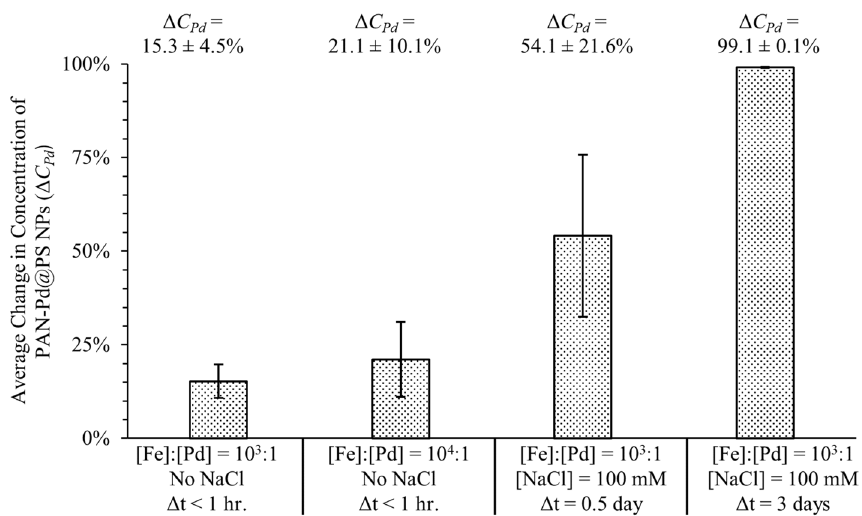
Fig. 3 Conditions for optimal removal of PAN-Pd@PS NPs. Average decrease in concentration of PAN-Pd@PS NPs in suspension (Δ C Pd ) in response to varying [Fe]:[Pd] mass concentration ratio, concentration of NaCl, and interaction time between HDTMS-FeNPs and PAN-Pd@PS NPs. Error bars indicate 1σ ( n ± =